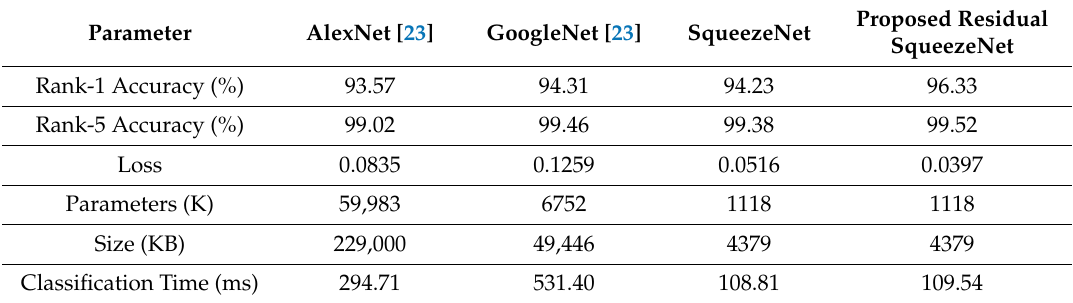
Table 6. Proposed residual SqueezeNet in comparison with the state-of-the-art deep learning models.